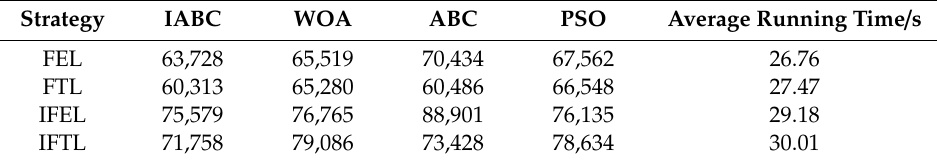
Table 6. Comparison of objective function values using di ff erent